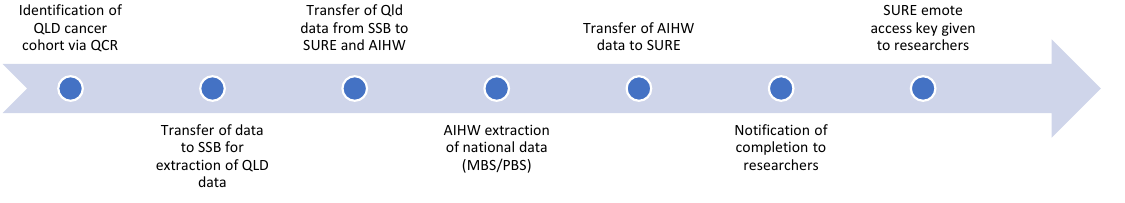
Figure 1. Data linkage process.